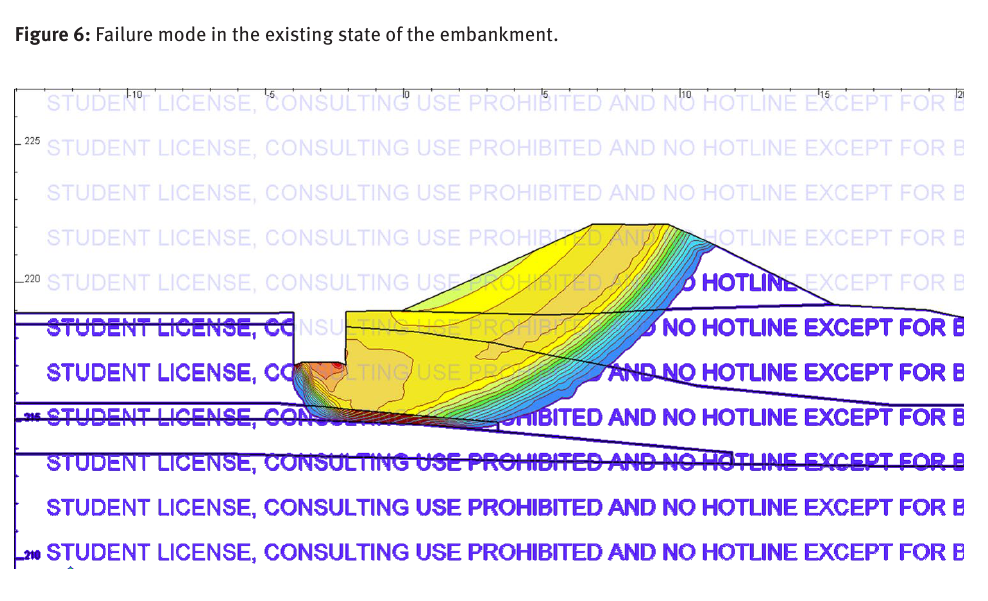
Figure 7: Failure mechanism of the embankment with shallow excavation, the same in all phases of the